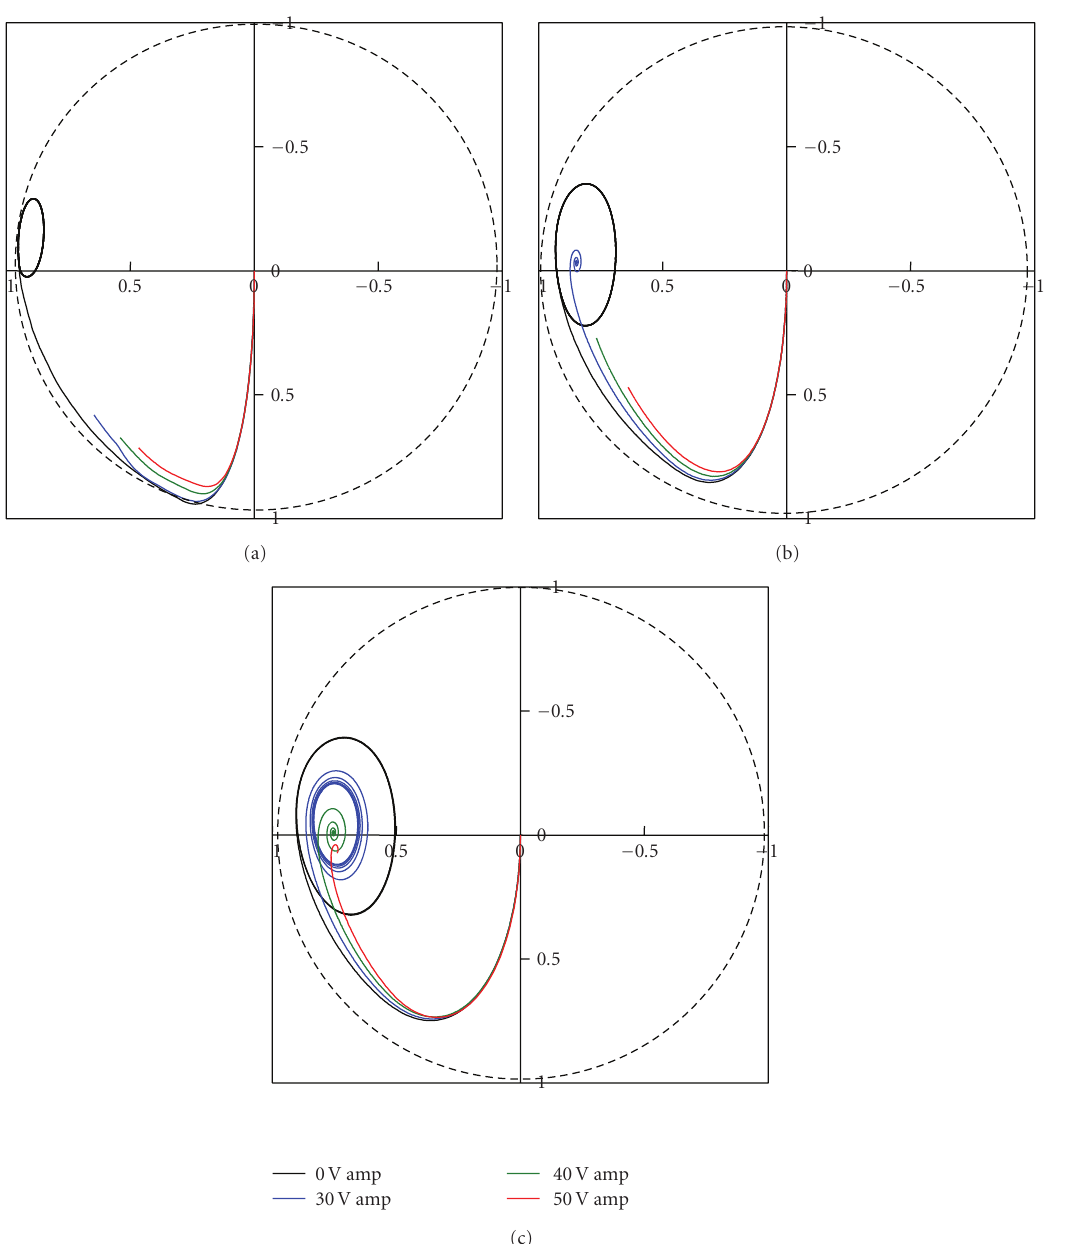
Figure 6: Quasistatic results for three-lobe bearing with squeeze-film e ff ect, ω = 1500Hz, 56.65g load: (a) Ω = 320rpm, (b) Ω = 630rpm, (c) Ω = 1020rpm. Trajectories path of rotor centre are expressed as a ration of rotor centre position over bearing clearance.